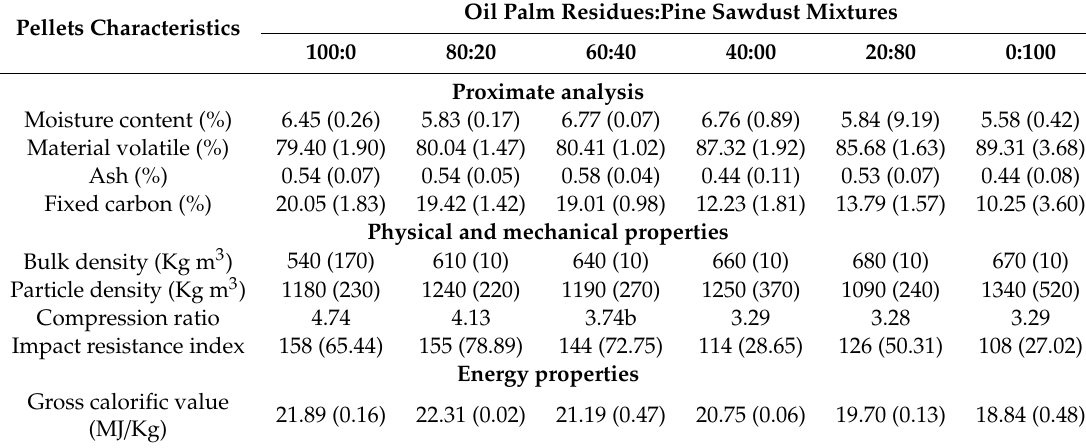
Table 2. Proximate analysis, physical and mechanical characteristics of agro-pellets produced at di ff erent oil palm residues: pine sawdust